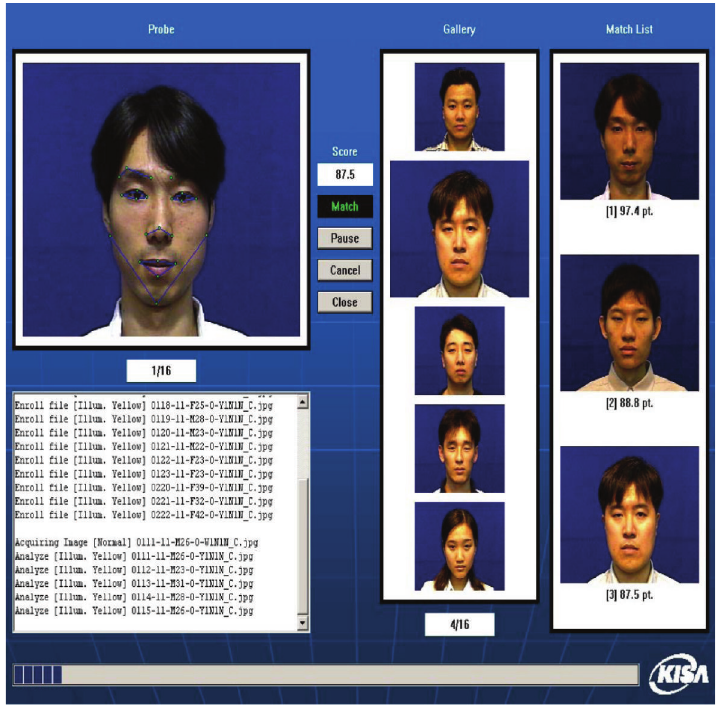
Figure 5: Progress visualization when evaluating